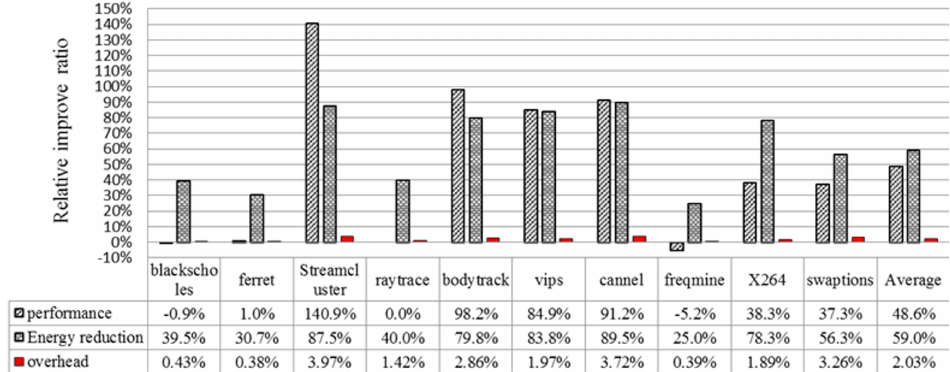
Figure 10. Performance, energy reduction, and overhead improvement ratio compared to the